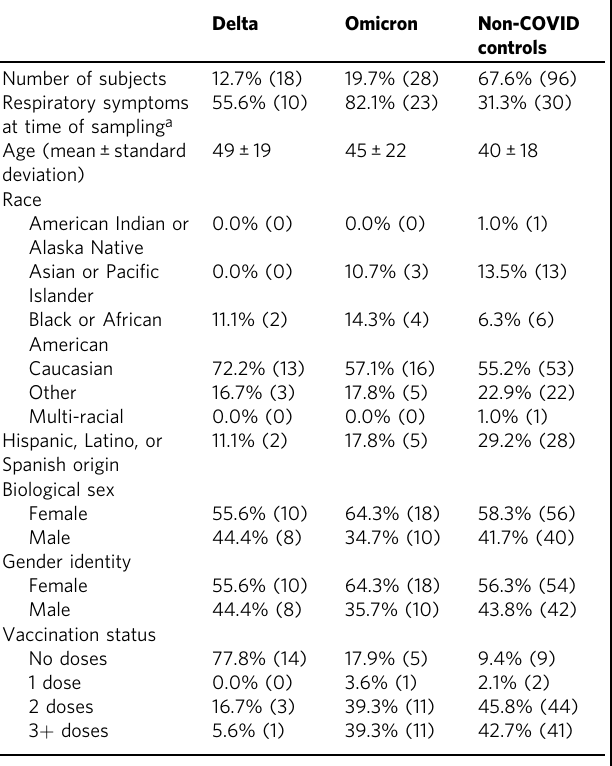
Table 1 Demographic